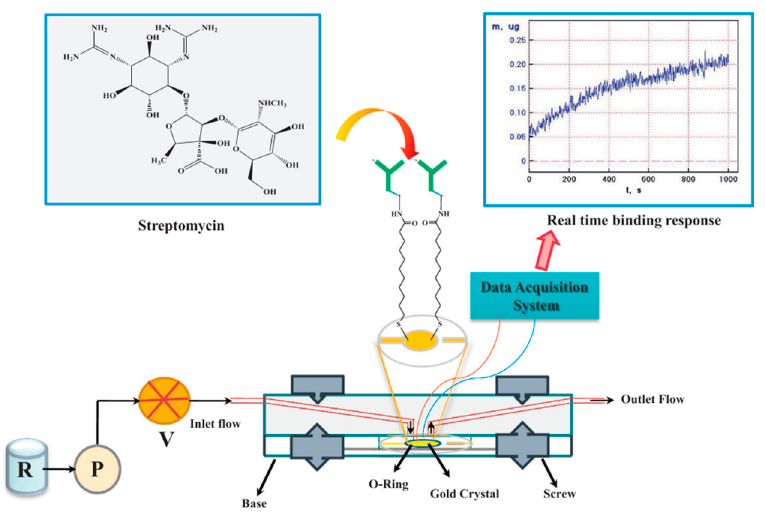
Figure 3. Schematic of flow injection analysis–electrochemical quartz crystal nonequilibrium (FIA-EQCN) biosensor for analysis of streptomycin in milk [122] (Reproduced with permission from Elsevier Ltd.).